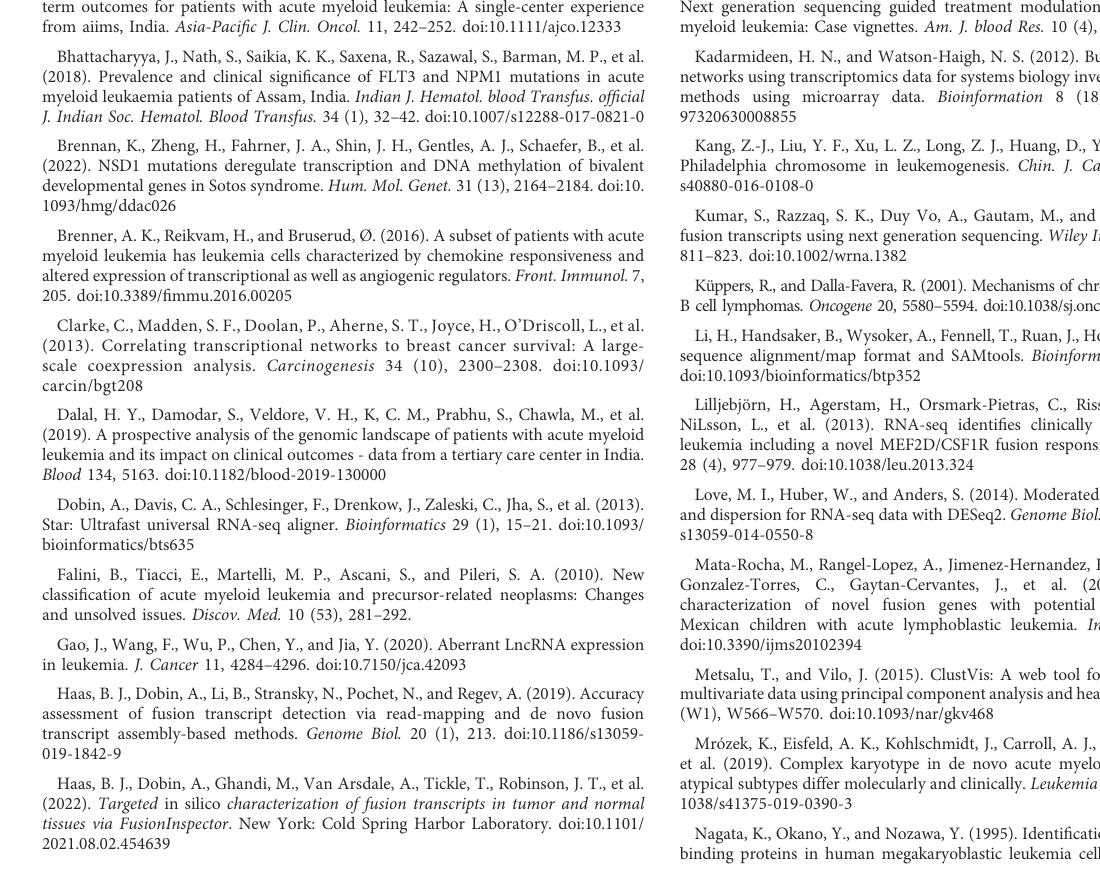
SUPPLEMENTARY FIGURE S2 (A) ORF sequence predicted by the orf maker using the fusion transcript, along with the amino acid sequence of the orf. The amino acid sequence shows similarity with arf-GAP GTPase domain on performing a protein blast. (B) TheorfsfromthepartnergenesinthefusiontranscriptHOXD11and AGAP3 along with their protein domains. SUPPLEMENTARY FIGURE S3 Boxplot showing the difference in TTYH expression between control and AML samples and a Kaplan Meier plot showing signi fi cant difference in survival probabilities between low and high TTYH3 expression. SUPPLEMENTARY FIGURE S4